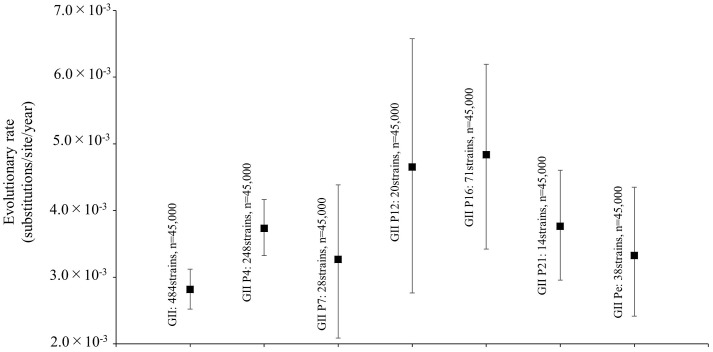
Evolutionary rates of the full-length nucleotide sequences of the norovirus RdRp regions. The y-axis represents the evolutionary rate (substitutions/site/year) and the x-axis represents each genotype. The black squares indicate the mean and the bars indicate the interval of 95% HPD. The statistical results for multiple comparisons between the RdRp genotypes are shown in Supplementary Table S2.